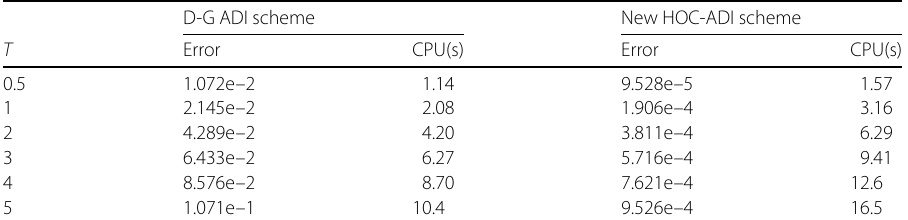
Table 4 Comparison of maximum errors at different time T for the equation in Example 2, h = 2 π /15, time step τ = 0.01